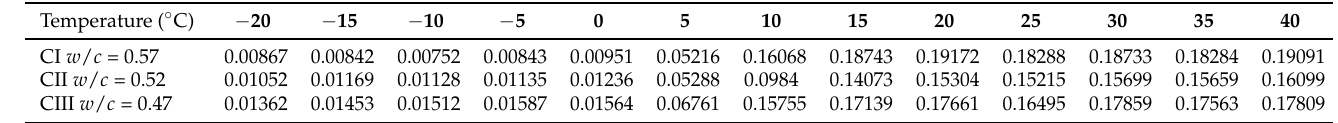
Figure 11. Variation of nonlinear parameter A 2 / A 2 parameter A 2 / A 2 of CI; ( b ) nonlinear parameter A 2 / A 2 1 Table 4. The measured average relative nonlinear